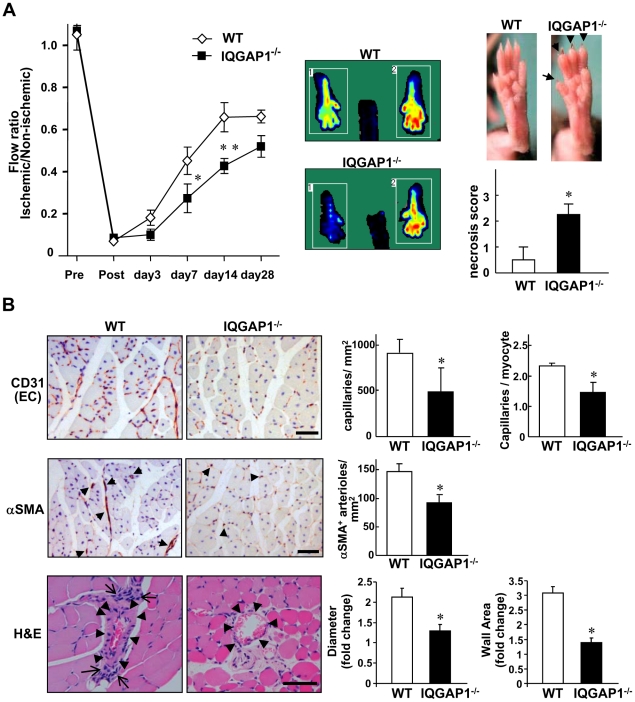
Post-ischemic revascularization is impaired in IQGAP1−/− mice.
A, Left, blood flow recovery after hindlimb ischemia in wild-type (WT) and IQGAP1−/− mice, as determined by relative values of laser Doppler perfusion of the plantar sole between ischemic (left) and non-ischemic (right) legs (WT, n = 13; IQGAP1−/−, n = 10, **p<0.01 and *p<0.05). Middle panels show representative perfusion images at day 14. Right, tissue necrotic score on the ischemic feet was determined (n = 10 *p<0.05). In IQGAP1−/−, the necrotic score represents severe phenotype with edematous fingers and degenerative nail beds (black arrows). B, Tissues were harvested at day 14 for histological analysis. CD31 positive capillary-like ECs (top) and α-smooth muscle actin (αSMA) positive arterioles (middle) in ischemic gastrocunemius muscles. Positive staining (red brown) and nuclei (purple) are shown. Bars represent 50 µm. The graphs represent the number per mm in 2 area and/or per muscle fibers (n = 4, *p<0.05). Hematoxyline and eosin (H&E) staining of adductor muscles (bottom). Arrowheads show collateral vessels in semimembranosus muscle. Prominent cellular infiltration in adventitia and perivascular area in WT mice are shown by arrows (left). The diameter and wall area are calculated from the measurements of luminal and perivascular tracing (right). Data shown are mean+/−SEM.